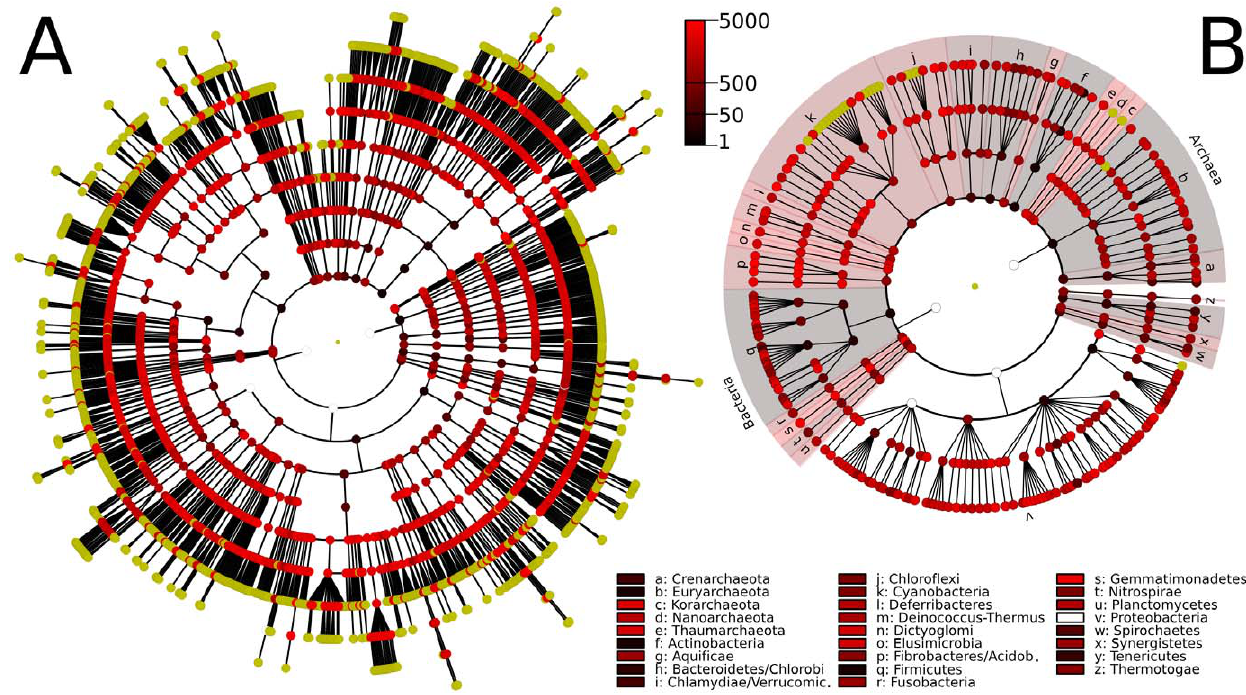
Figure 1. Evolutionarily conserved core gene sets calculated using the NCBI Taxonomy as a guide tree. In the circular cladograms each node represents a taxon, ranging from phyla (internal) to genera, species, and in some cases strains and sub-strains (external) with yellow leaf nodes representing taxa for which a complete genome is available. Core genes for higher-level clades are indicated by color (from black to red) proportional to the logarithm of the number of core genes, and white circles represent clades without cores. A) The full tree of core gene sets, representing 2,861 clades and 1,107 sequenced organisms. This tree includes the Bacteria and Archaea and results in cores that are functionally enriched for housekeeping genes including basic DNA and RNA operations. B) The core gene tree limited for visual clarity to the family. Note that our core gene discovery algorithm reflects for differences in phylogenetic depth and includes fewer core genes for broader clades spanning greater diversity.